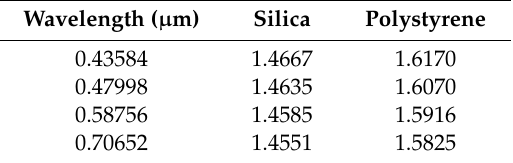
Table 1. Wavelength dependent refractive index for silica and polystyrene